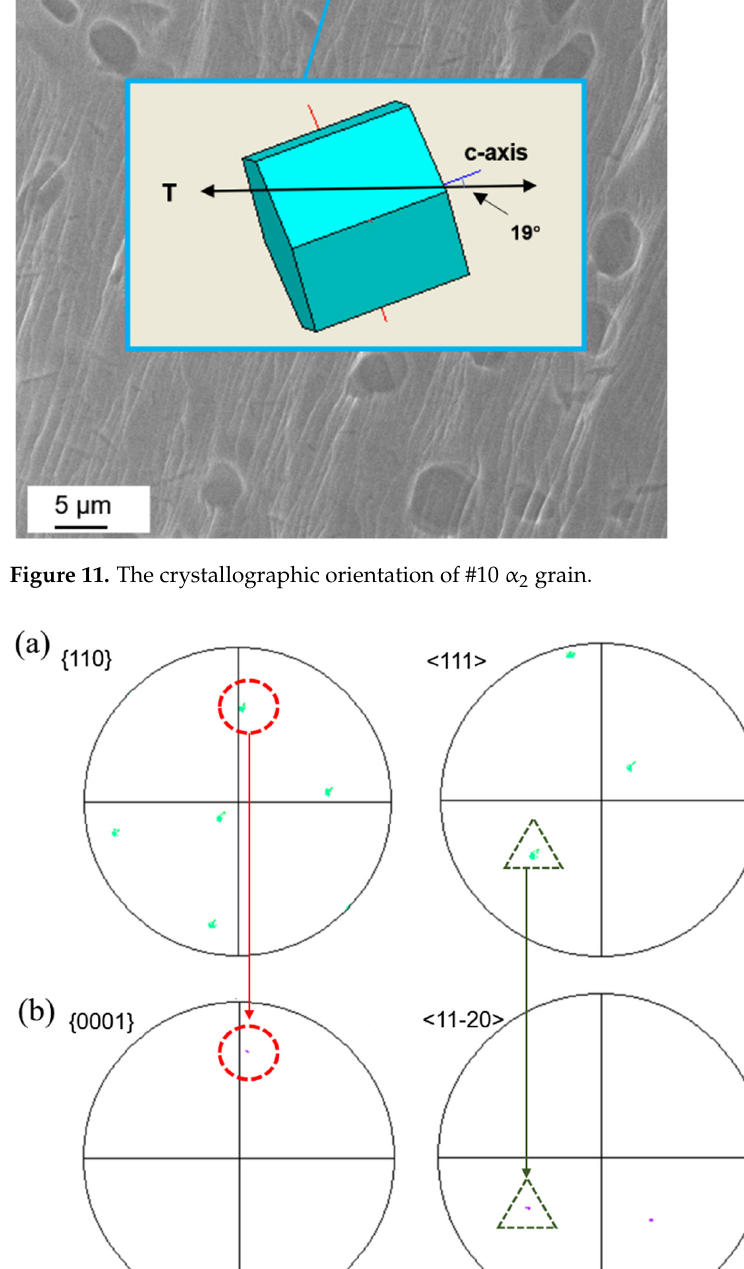
Figure 12. ( a ) {110} and <111> pole figures of the B2 phase, ( b ) {0001} and <1120> pole figures of the #22 α 2 particle.